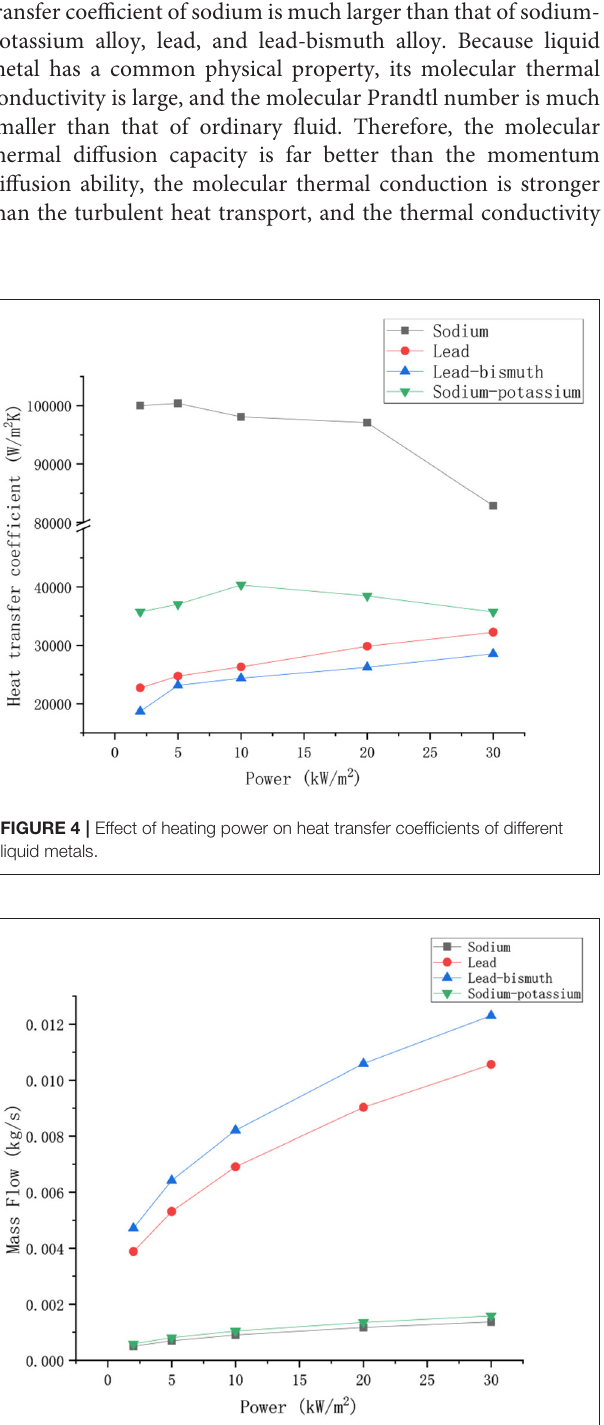
FIGURE 3 | Grid sensitivity analysis.